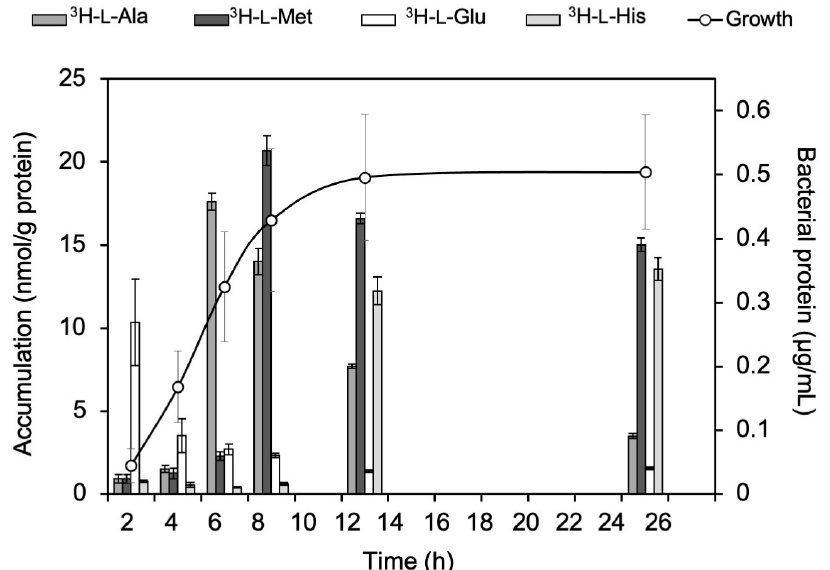
Figure 1. Accumulation of 3 H-L-Ala, 3 H-L-Met, 3 H-L-Glu, and 3 H-L-His in E. coli K-12 at each growth stage. At 2 h, 3 H-L-Glu showed the highest accumulation. At 6 h and 8 h, 3 H-L-Ala and 3 H-L-Met accumulated more than the other amino acids. At 12 h and 24 h, the accumulation of 3 H-L-Met and 3 H-L-His was higher than that of the other amino acids.